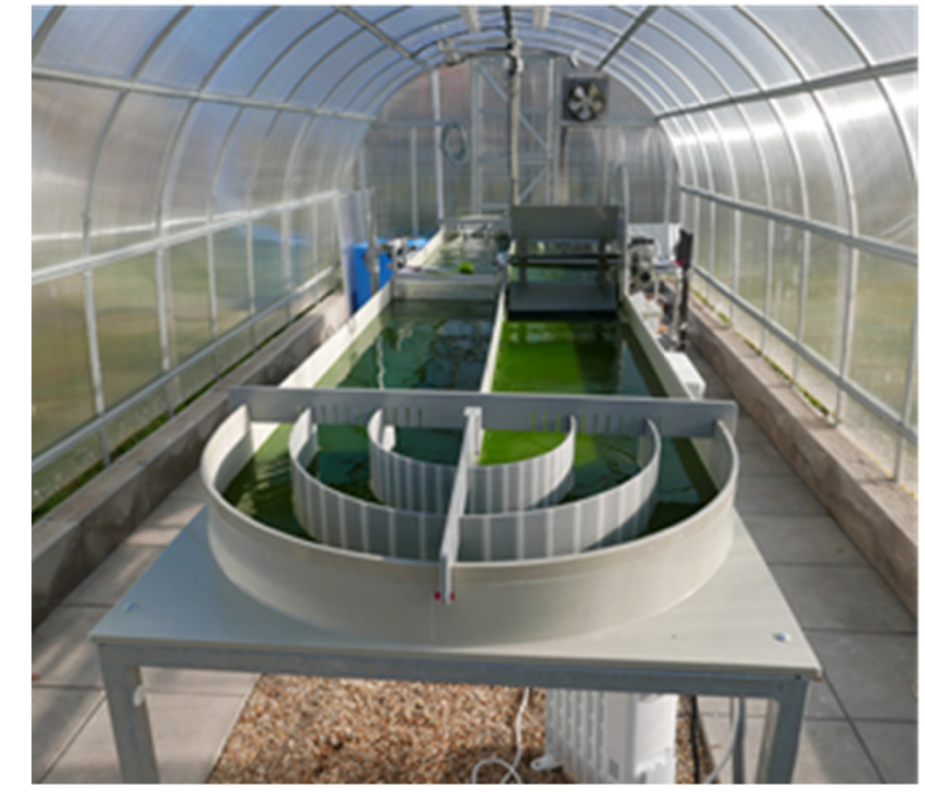
Figure 6. Thin-layer raceway pond used for the cultivation of Monoraphidium. The unit of 5 m 2 with a working volume of 100 litres was placed in a polycarbonate greenhouse to protect against un-favourable weather conditions and cross-contamination (Centre Algatech Tˇreboˇn). Temperature control was maintained by heaters and fans to keep a suitable cultivation regime. The culture layer thickness in the unit was between 15–25 mm and flow velocity about 0.2 m s − 1 managed by a paddle wheel